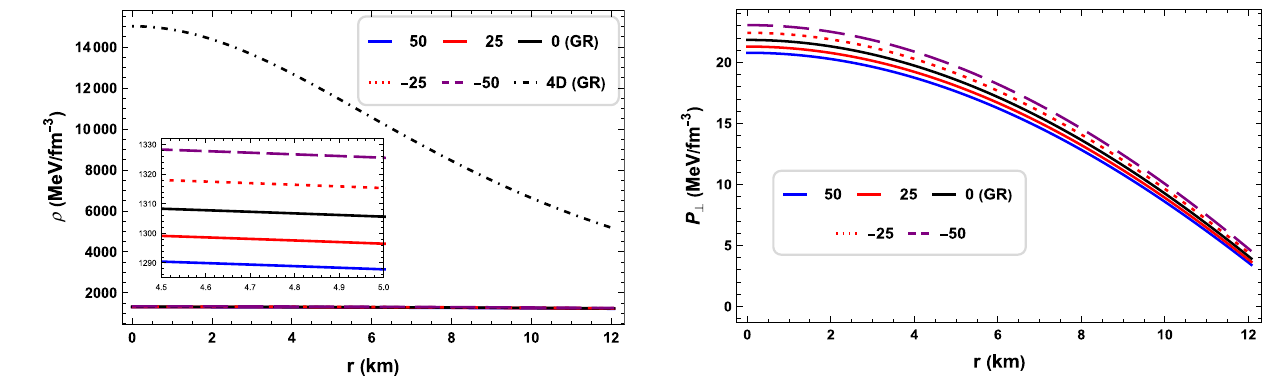
Fig. 3 Radial variation of transverse pressure ( P ⊥ ) in PSR J0348+0432 for different α values in 5D